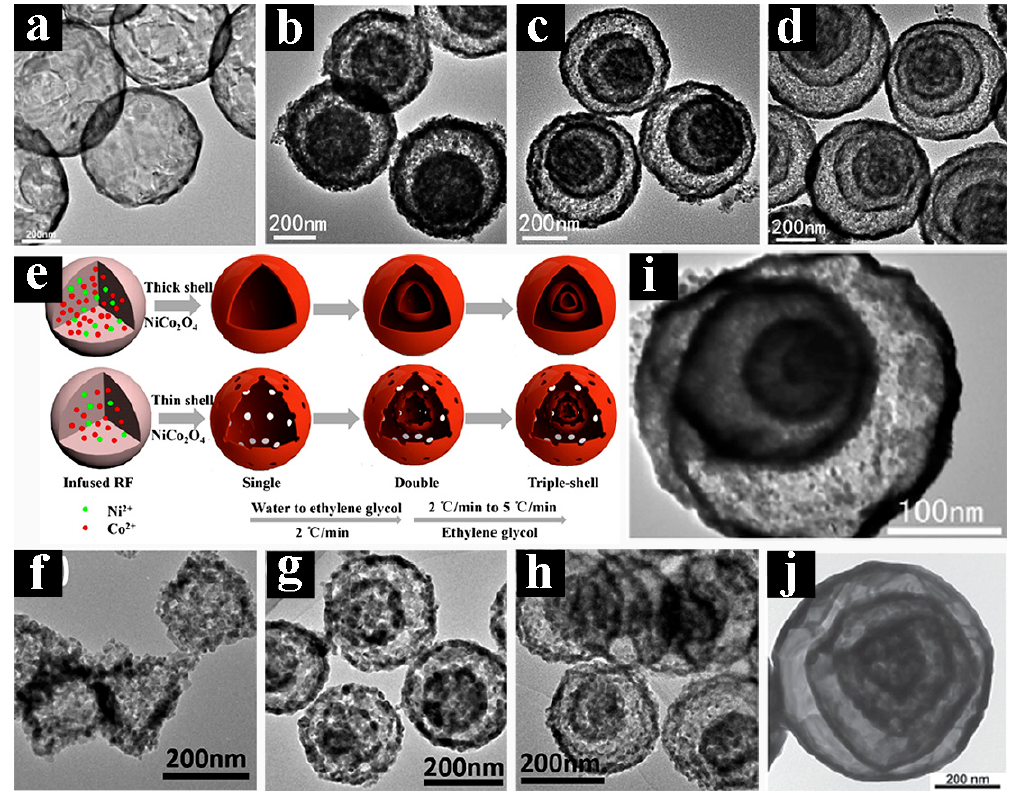
Figure 7. Schematic demonstration and graphical illustration of multi–shells structure synthesized by hard-templating method: transmission electron microscopy (TEM) images of cobalt oxide (Co 3 O 4 ) ( a ) single-shelled hollow spheres (SSHSs), ( b ) double-shelled hollow spheres (DSHSs), ( c ) triple-shelled hollow spheres (TSHSs), and ( d ) quadruple-shelled hollow spheres (QSHSs). ( e ) Scheme of the formation of NiCo 2 O 4 hollow microspheres with tunable numbers and thickness of shell, TEM images of NiCo 2 O 4 ( f ) thin SSHSs, ( g ) thin DSHSs, and ( h ) thin TSHSs. ( i ) HRTEM image of the WO 3 MSHSs [131]. ( j ) TEM image of α -Fe 2 O 3 QSHSs [132]. Pictures ( a ), ( b ), ( c ), and ( d ) were reprinted with permission from Reference [129]. Copyright Wiley, 2013. Pictures ( e ), ( f ), ( g ), and ( h ) were reprinted with permission from Reference [130]. Copyright Elsevier, 2017. Picture ( i ) was reprinted with permission from Reference [131]. Copyright Wiley, 2012. Picture ( j ) was reprinted with permission from Reference [132]. Copyright the Royal Society Chemistry, 2013.